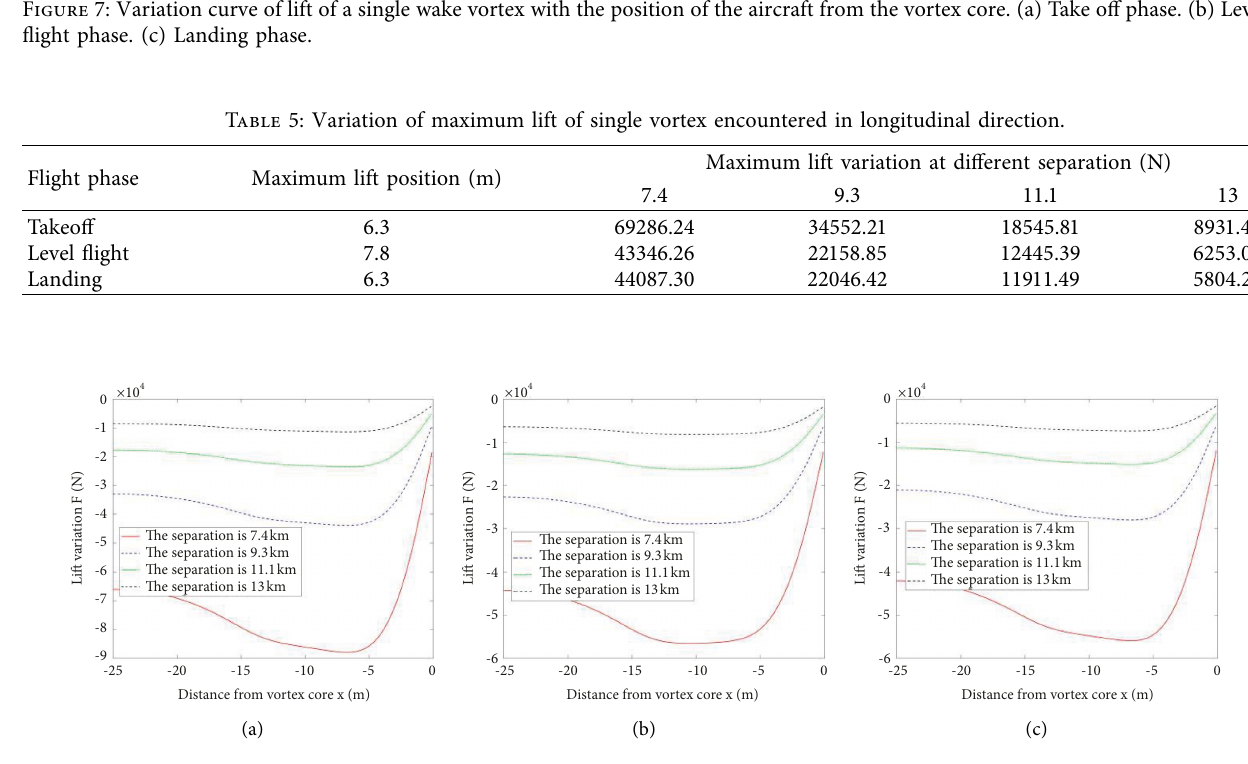
Figure 8: Variation curve of double vortex lift with aircraft distance from vortex core. (a) Takeoff phase. (b) Level flight phase. (c) Landing